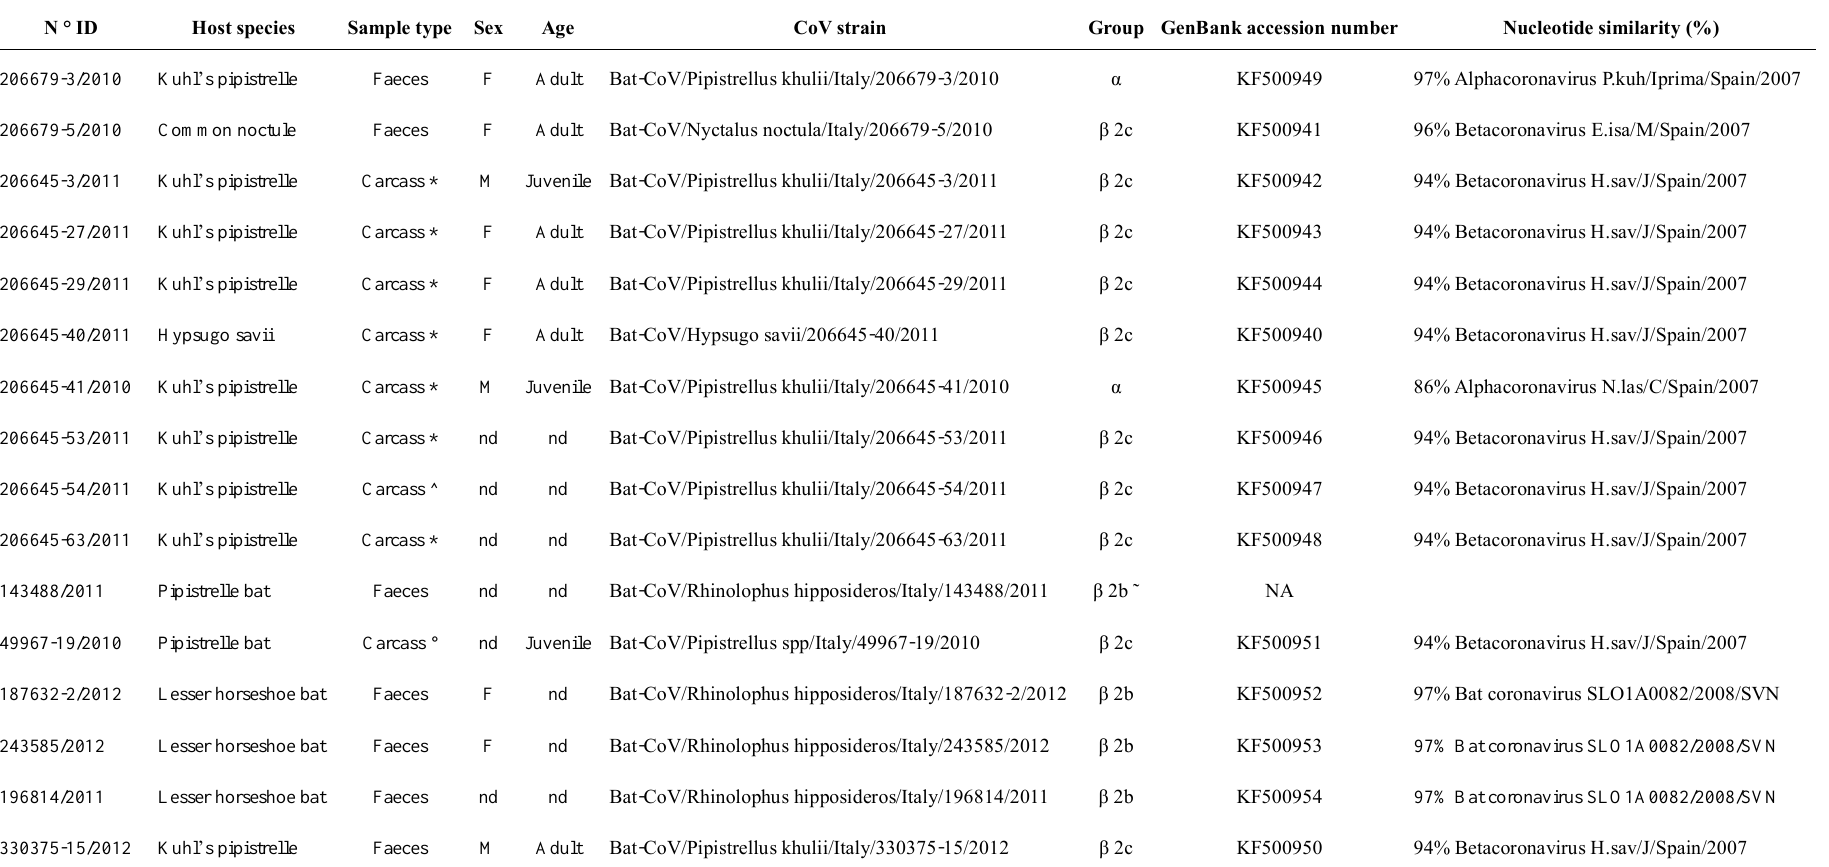
Table 2. List of positive samples with the GenBank accession number assigned to the gene